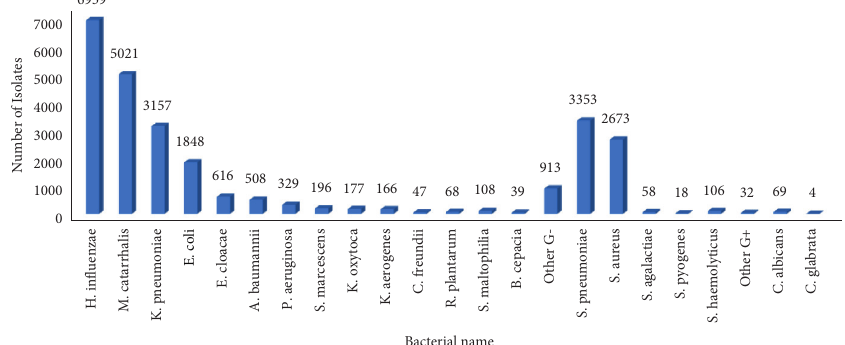
Figure 1: Isolated pathogens of lower respiratory tract from 2011 to 2020.